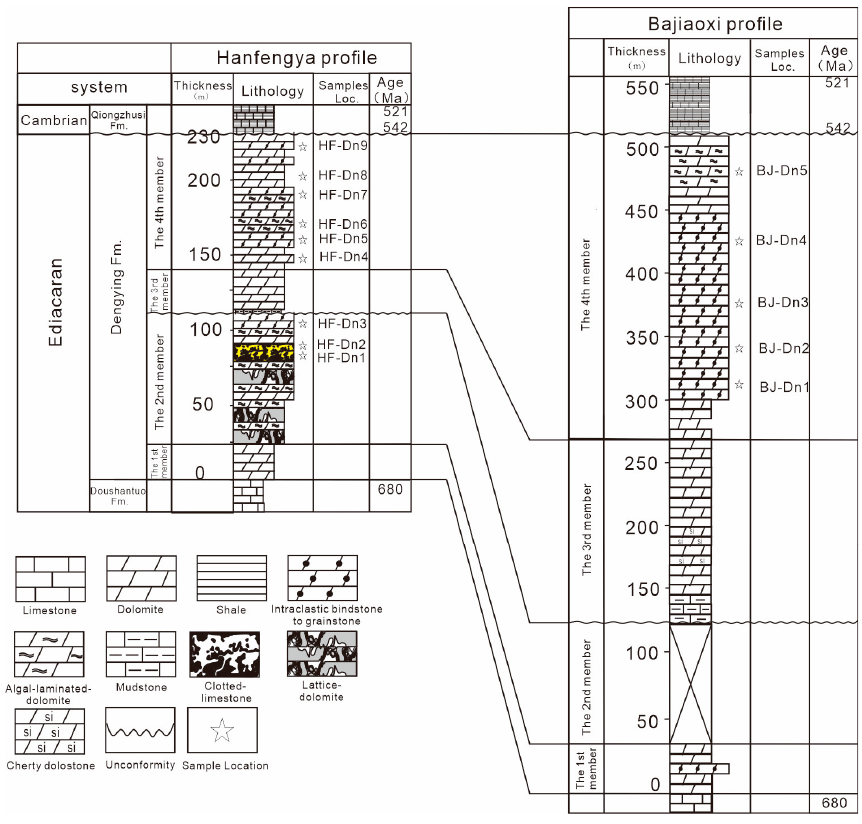
Figure 3. Cross section showing lithology and stratigraphic distribution of algal dolomite in the platform margin microbialite reef facies.